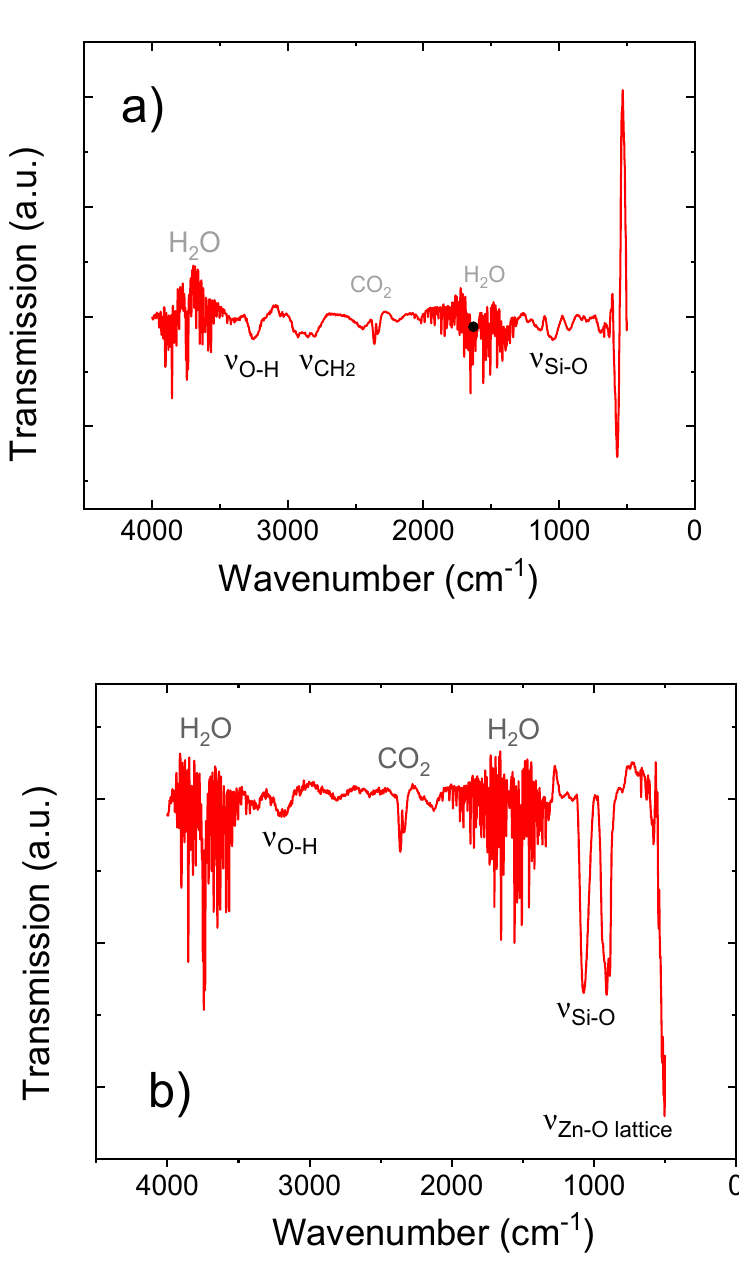
Figure 11. FTIR spectroscopy for samples calcinated at ( a ) 400 °C and ( b ) 600 °C. Applying Equations (5) and (7) to the refractive index variation with RH (Figure 12a), the volume fraction of all pores filled with condensate as a function of the maximum radius of these pores was calculated. Hence, Figure 12c can be interpreted as the cumulative distribution of open pores with respect to the pore radius. Therefore, its derivative yields the according PSD (Figure 12d). Due to limitations in the experimental setup, the RH could not be increased beyond 83%, restricting the detectable pore size to r pore < 2.8 nm (as it can be calculated from Equation (7)). Figure 12b shows the volume fraction of all pores that are filled with condensate at a specific